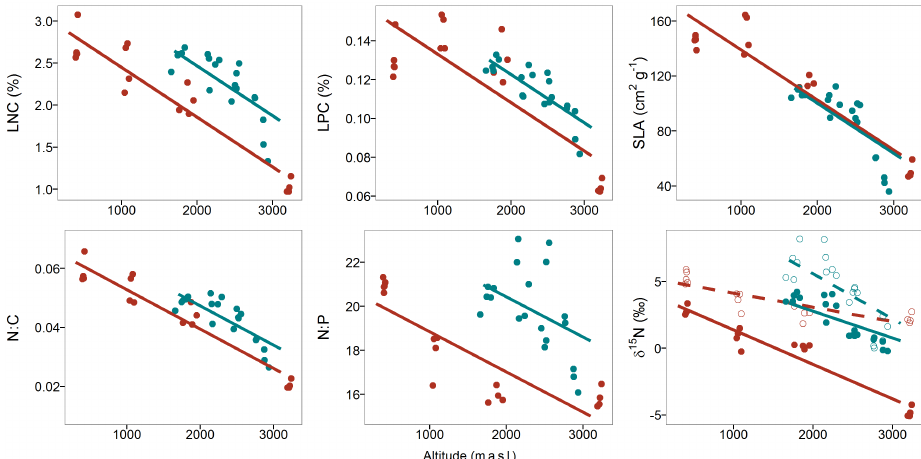
Figure 1. Trends in community-level functional traits and leaf (full line, closed circles) and topsoil (dashed line, open circles) δ 15 N of the elevation transects in Ecuador (red) and Rwanda (blue). Leaf nitrogen content (LNC), leaf phosphorus content (LPC), specific leaf area (SLA), and leaf N : C, P : C and N : P ratio decrease with increasing altitude on both transects. Both transects showed decreasing values of δ 15 N, providing additional evidence for a more closed N cycle with increasing altitude. Lines represent the fixed altitude effects in the respective statistical models for both Ecuador (red, 400–3200ma.s.l.) and Rwanda (blue, 1600–3000ma.s.l.).